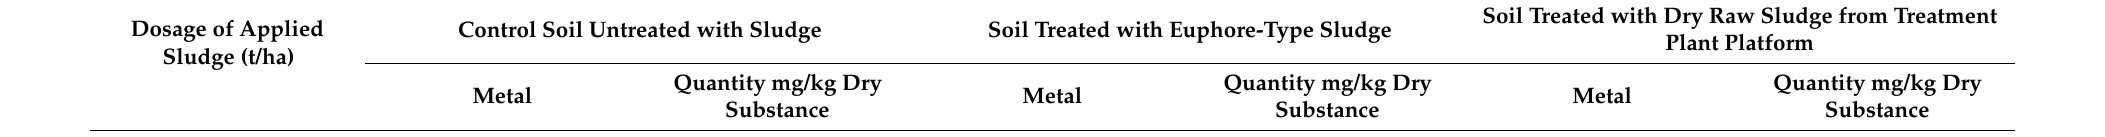
Table 9. The influence of different doses of sludge on the content of heavy metals in soybean stems, roots, and